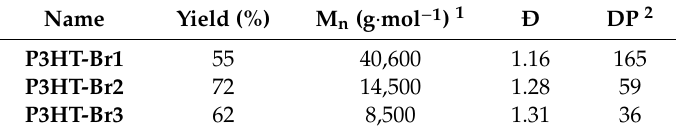
Table 1. Characteristics of the synthesized P3HT-Br precursors.